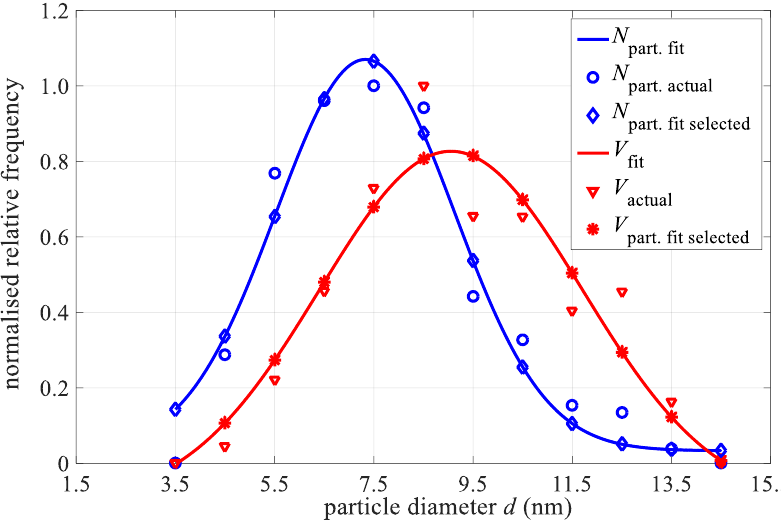
Figure 2. TEM images of the nanoparticles and the corresponding nanoparticle empirical size distribution (solid symbols) fitted with Gaussian curves (lines).